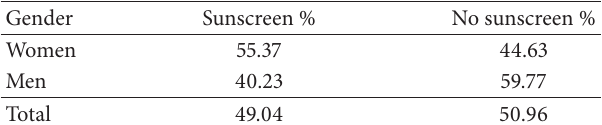
Table 1: Gender differences in dorsal hand UVR protection (women are more likely to apply sunscreen to their dorsal hands than men, 𝑃 = 0.04 ).